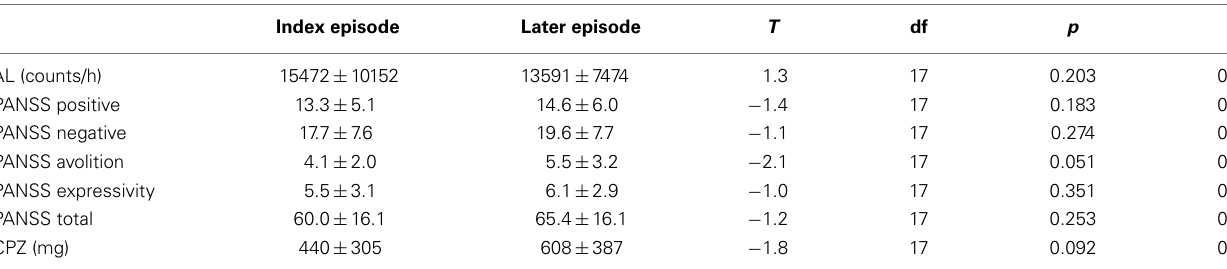
Table 3 | Paired T -tests between episodes .